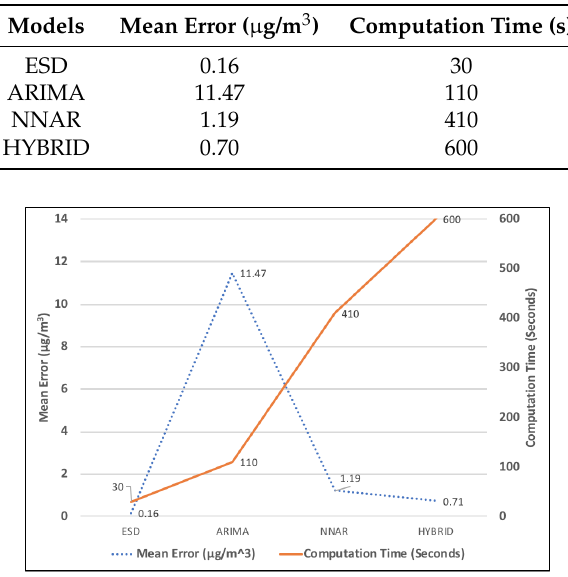
Figure 11. Mean error and computation time comparison with baseline